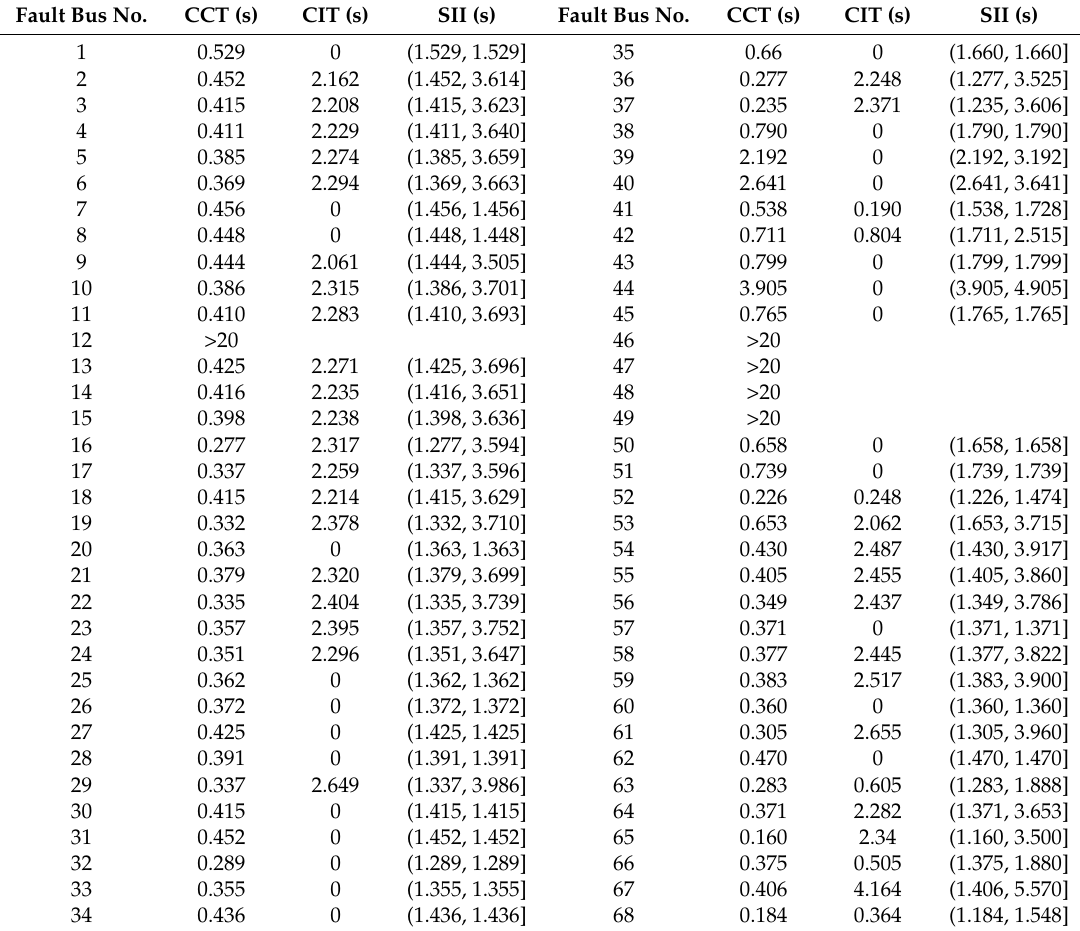
Table 1. The results of CCT, CIT, and SII for all cases of the NETS–NYPS interconnected power system. Fault Bus